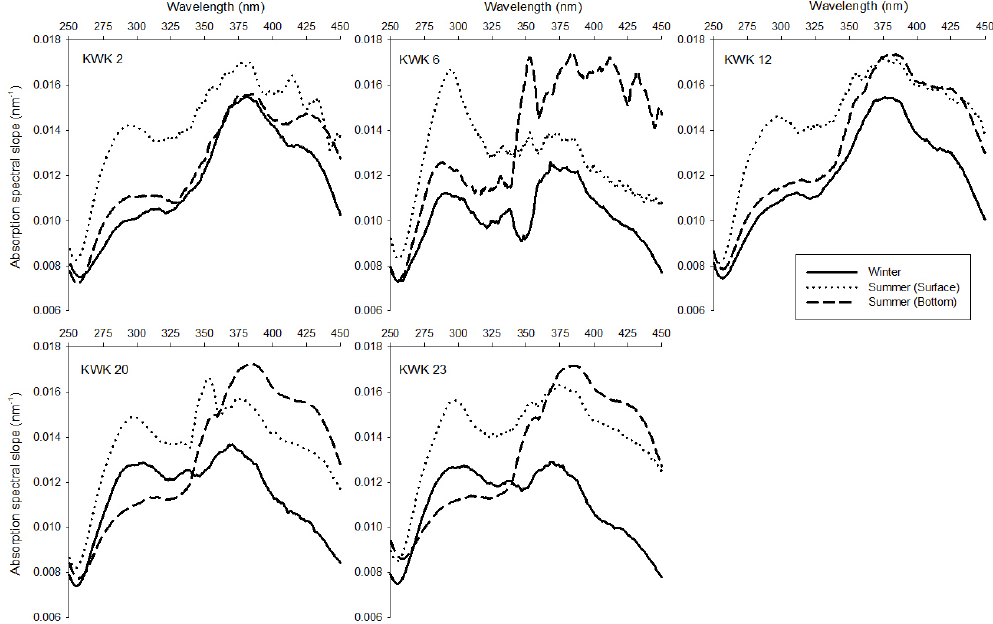
Figure 2. Absorption spectral slope curve ( S λ ) of dissolved organic matter as an indicator of the presence of algal-derived carbon (peak at S 289 ) and terrestrial carbon (steady increase in the slopes from 260 to